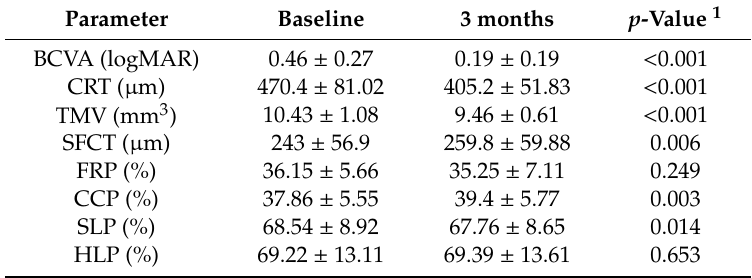
Table 3. Anatomical and functional parameters of iERM eyes before and 3 months after surgery.